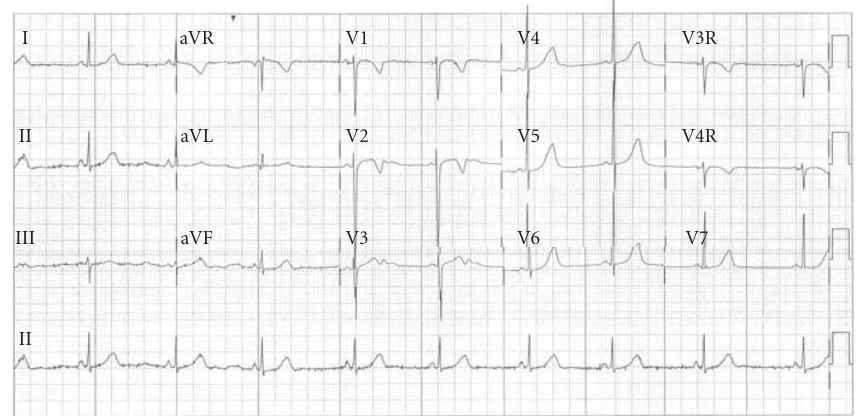
F 1: Baseline ECG showing sinus rhythm at 50–60bpm with normal PR, QRS, and QTc intervals.